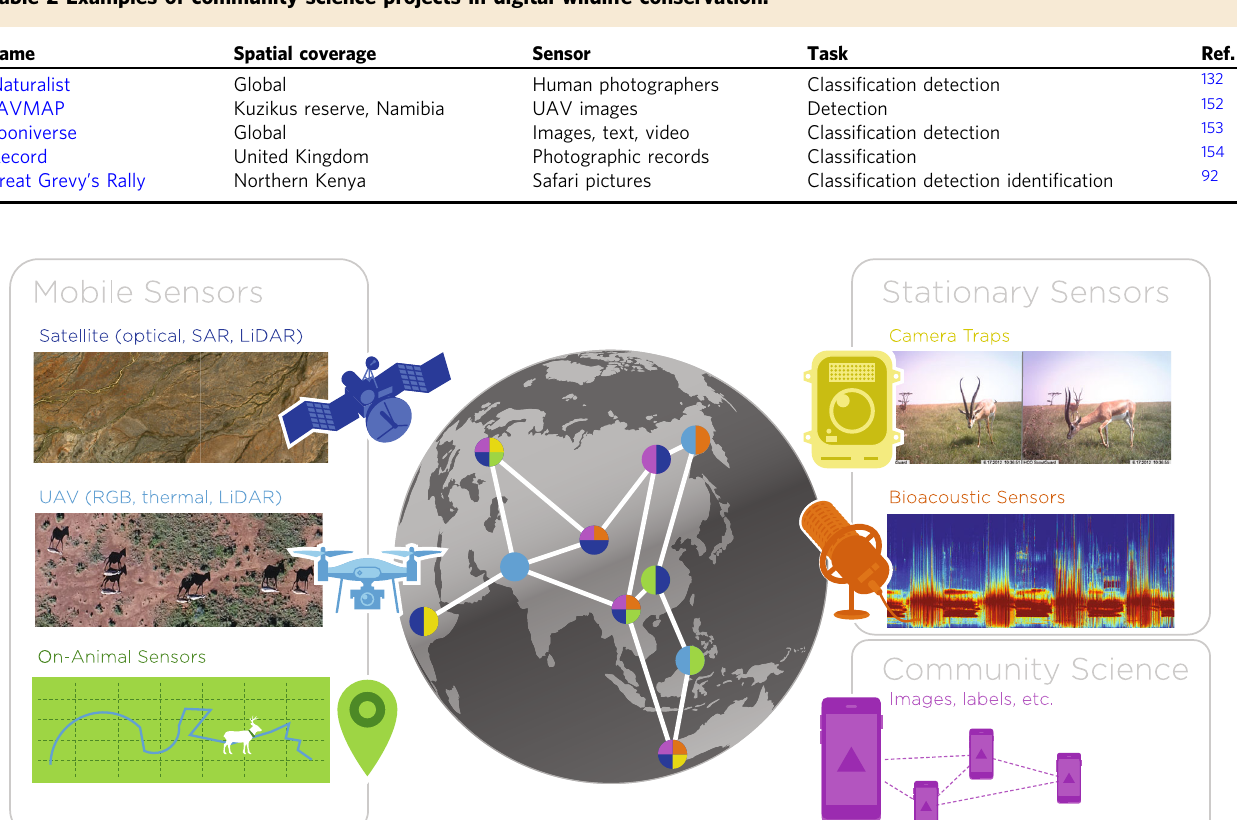
Table 2 Examples of community science projects in digital wildlife conservation.